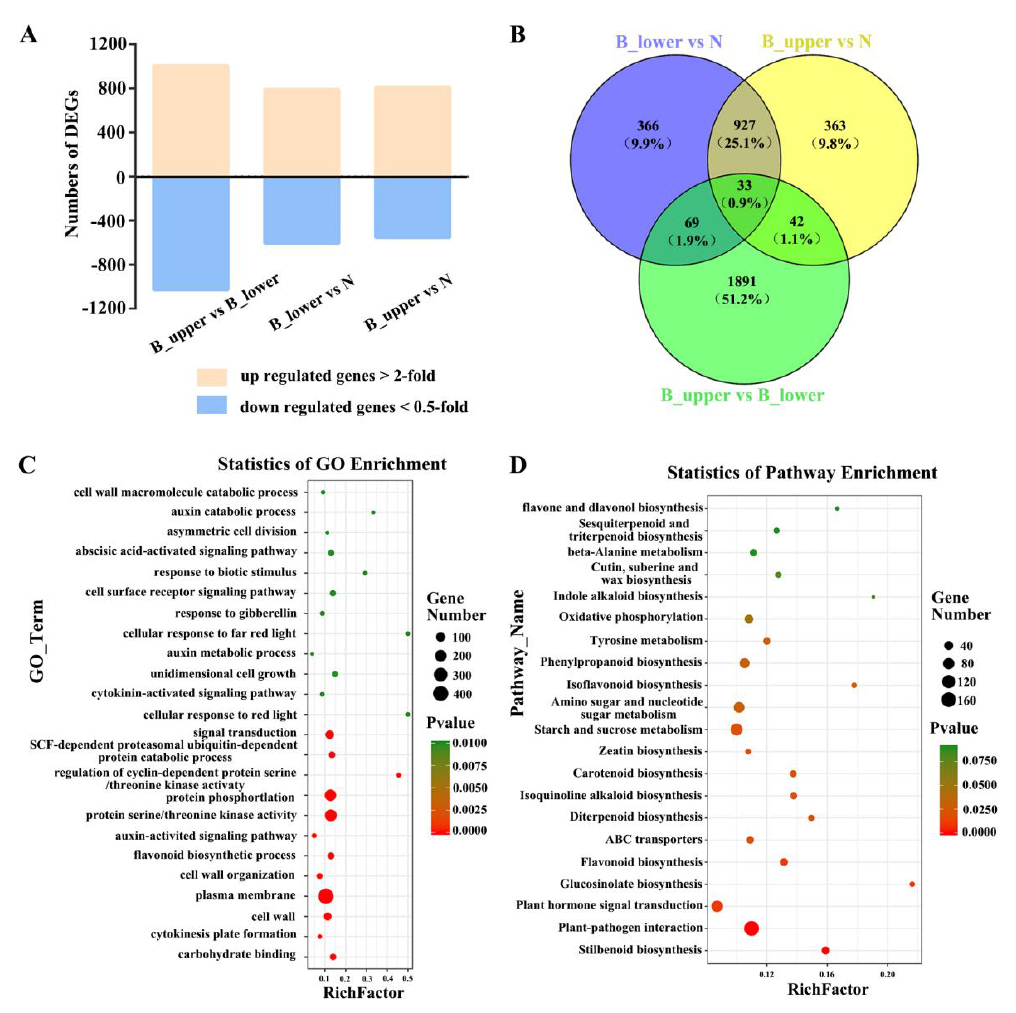
Figure 4. Numbers of DEGs between NP and BP and corresponding GO and KEGG enrichment data. ( A ) Numbers of up-regulated and down-regulated genes identified from comparison of B_upper and B_lower, B_upper and N, and B_lower and N. ( B ) Venn diagram of the data in A. ( C ) GO function enrichment analysis of DEGs. ( D ) KEGG pathway enrichment analysis of